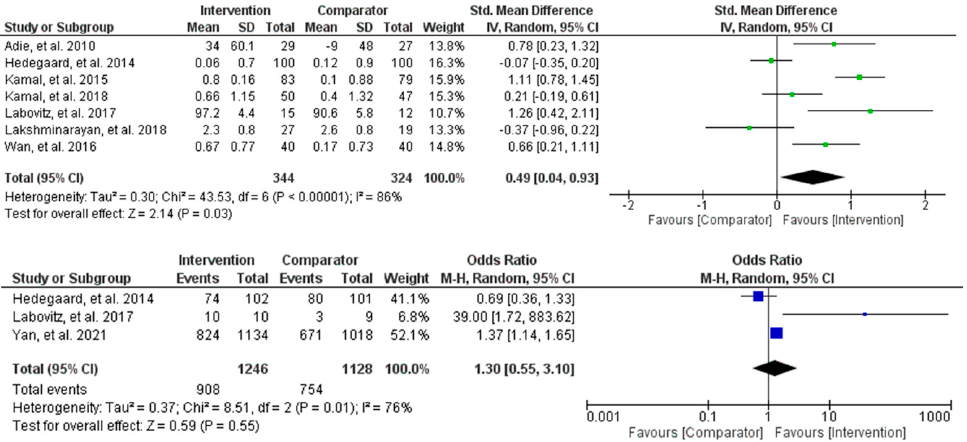
Figure 3. Meta-analysis results comparing changes in medication adherence mean scores and ratios between mHealth, telemedicine, and usual care groups.